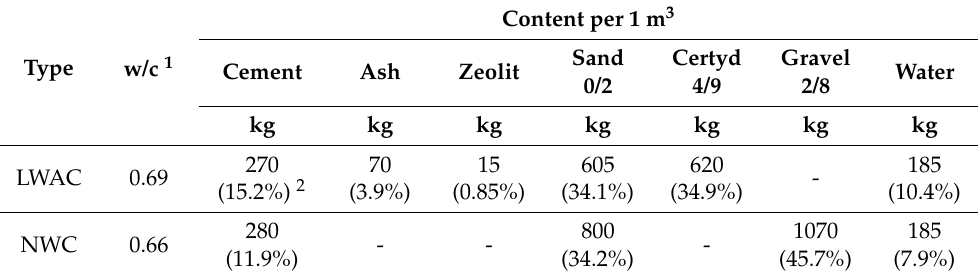
Table 3. Mixture proportions of the LWAC and NWC concrete.